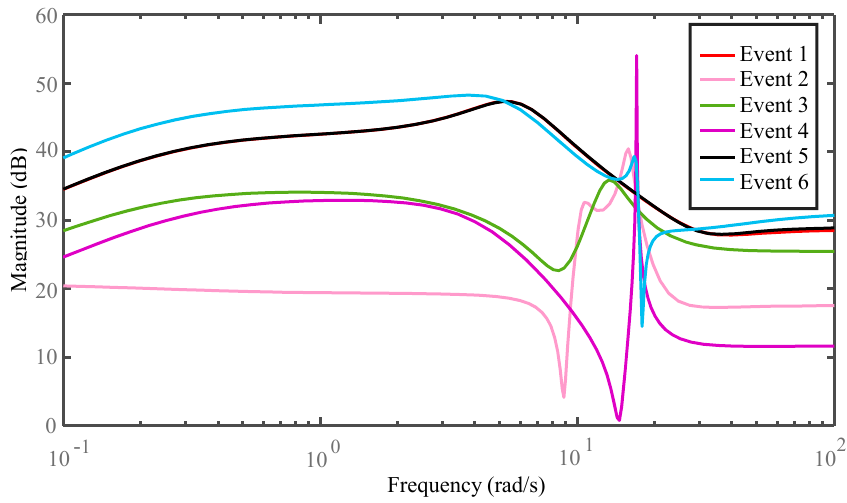
Figure 3. Bode diagram of models after events (linearization at t = 7.5 s).